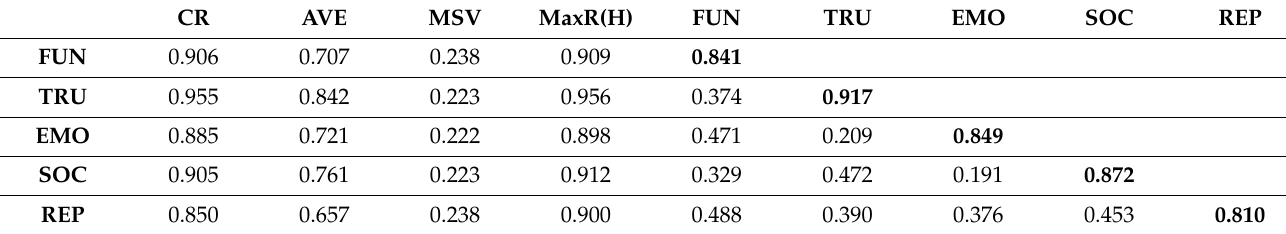
Table 3. Validity and Reliability Analysis.